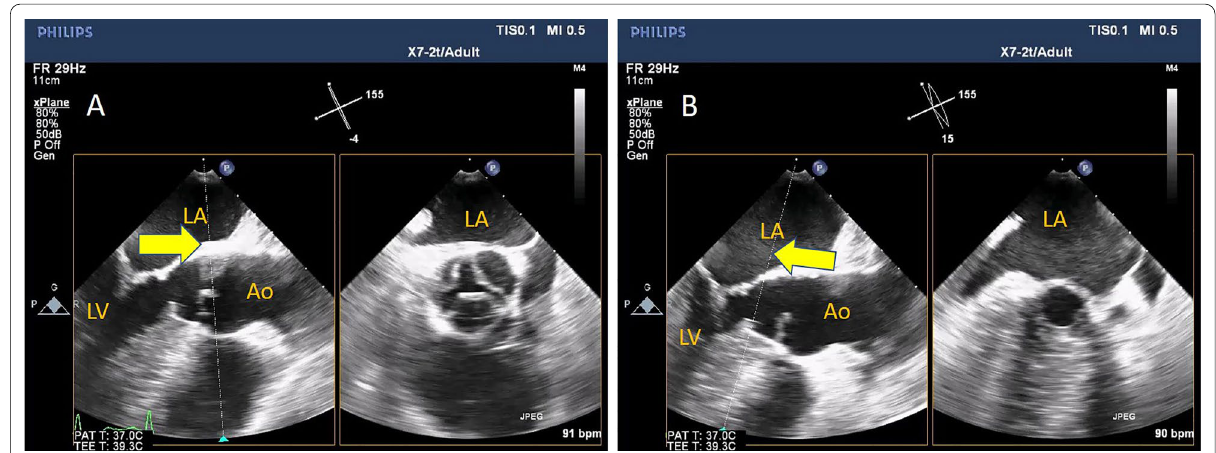
Fig. 4 X‑plane‑derived aortic valve area (panel A) and subaortic area at the level of the subaortic membrane (panel B)